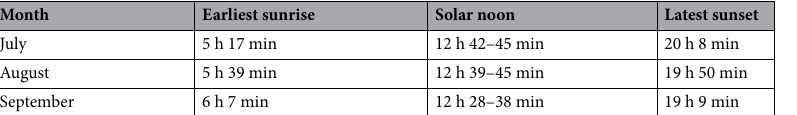
Table 1. The earliest sunrise, the temporal range of solar noon, and the latest sunset (standard local time) in July, August, and September in Boone County (39.0° N, − 84.75°